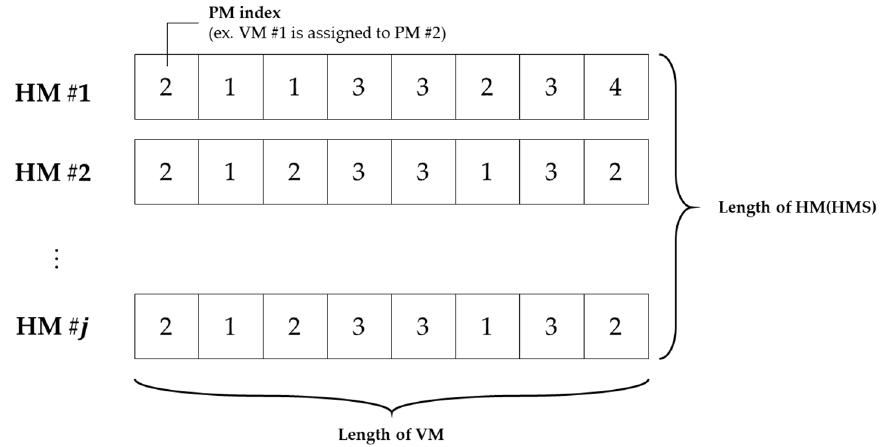
Figure 5. Solution representation for physical machine (PM)–virtual machine (VM) mapping.